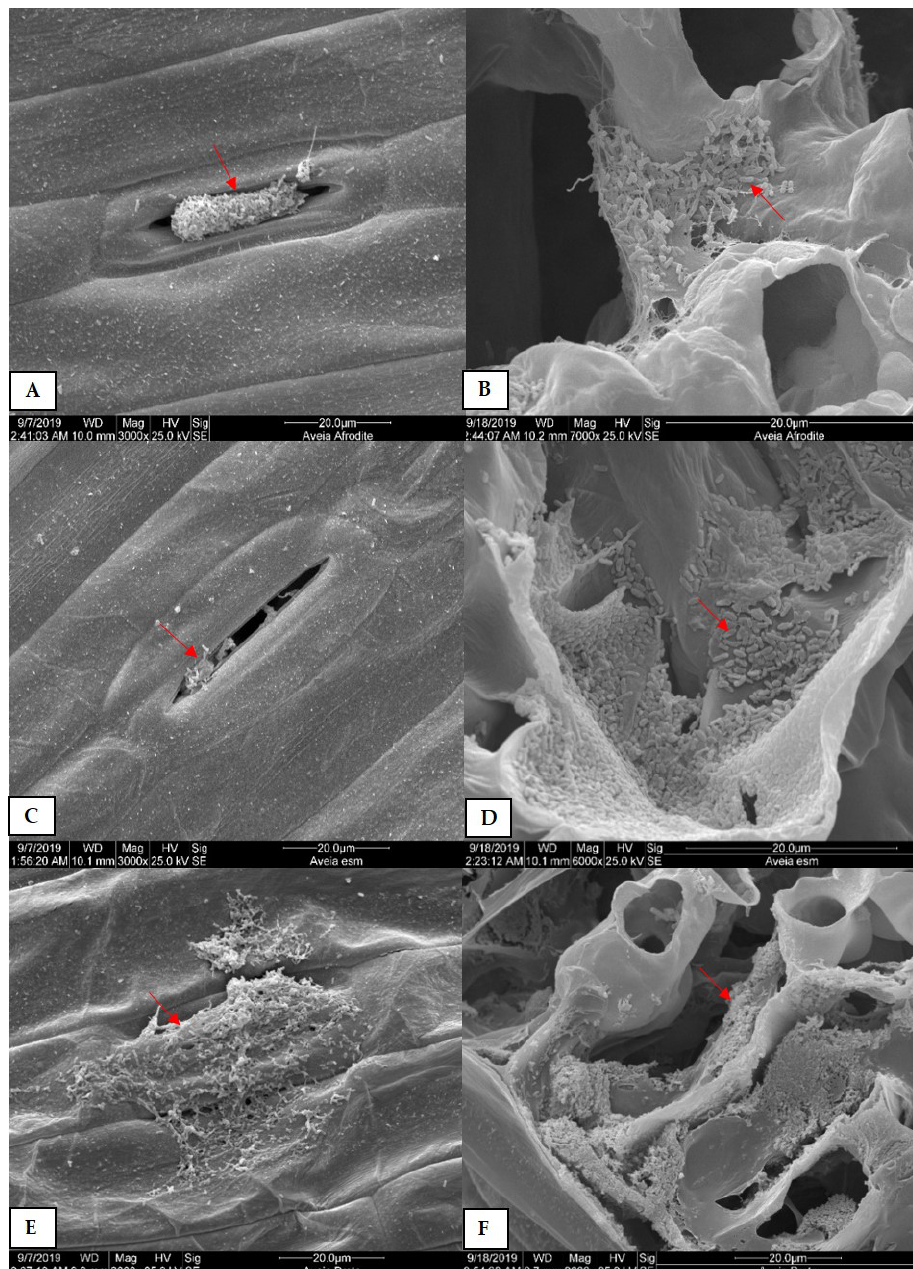
Figure 4. Scanning electron microscopy (SEM) of the leaf surface and leaf fractures of oat 15 days after inoculation (DAI) with Xanthomonas vasicola pv. vasculorum ( Xvv ). ( A ) Oat cv. IPR Afrodite with cluster of Xvv cells in the stomata (red arrow); ( B ) oat cv. IPR Afrodite with Xvv colonization in the leaf mesophyll with bacterial aggregates and production of amorphous material suggesting exopolysaccharides (EPS, red arrow); ( C ) oat cv. IPR Esmeralda with cluster of Xvv cells in the stomata (red arrow); ( D ) oat cv. IPR Esmeralda with Xvv colonization in the leaf mesophyll with bacterial aggregates and production of amorphous material suggesting EPS (red arrow); ( E ) black oat cv. IPR161 with cluster of Xvv cells in the stomata (red arrow); ( F ) black oat cv. IPR161 with Xvv colonization in leaf mesophyll with bacterial aggregates and production of amorphous material suggesting EPS (red